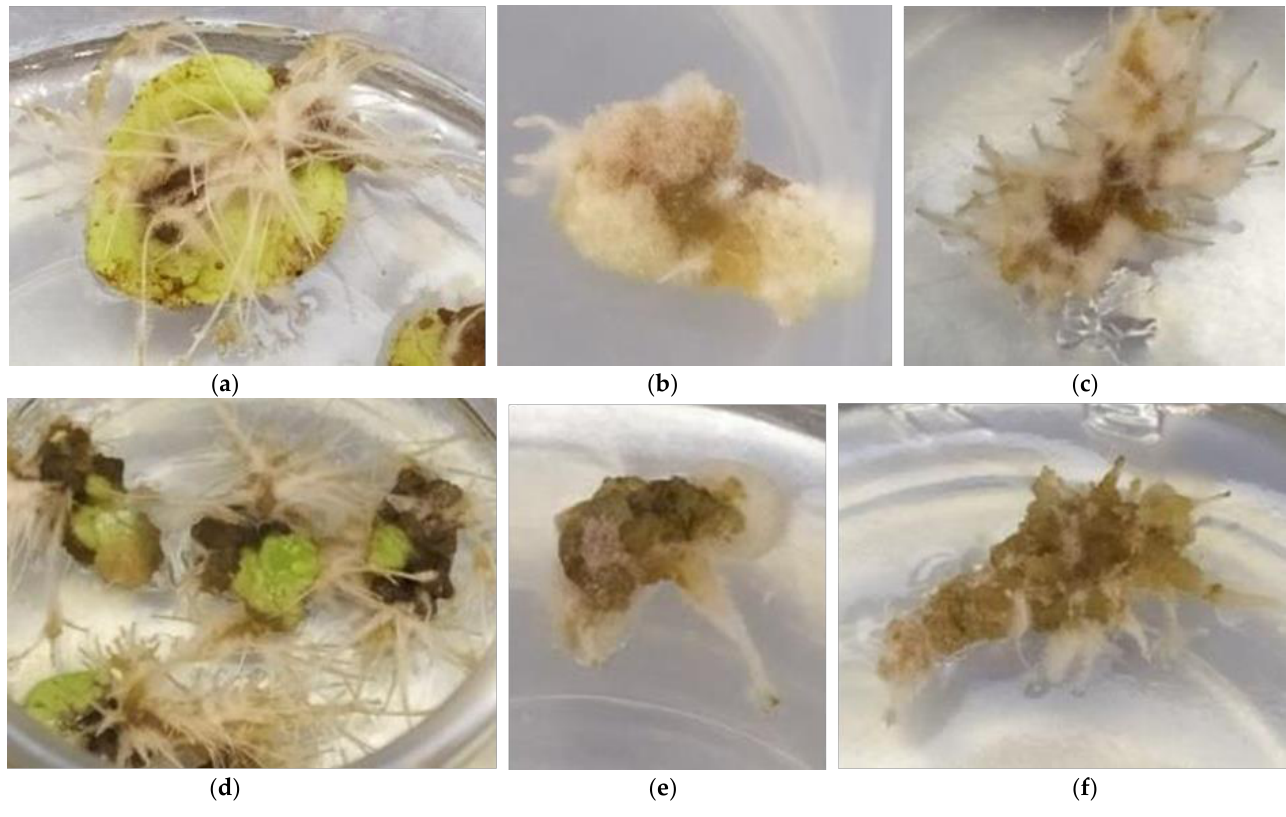
Figure 2. In vitro culture of three explant types (leaves, petioles, roots) of Origanum dictamnus L. in different media after two months: ( a ) root regeneration from leaves in ODK3, ( b ) callus and root formation from petiole explants in ODK3, (c) callus and new roots induction on root explants in ODK3 and ( d – f ) callus and root induction from leaf, petiole and root explants in ODK4, respectively.